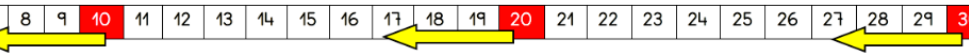
Figure 13. Number tape with some operations represented.